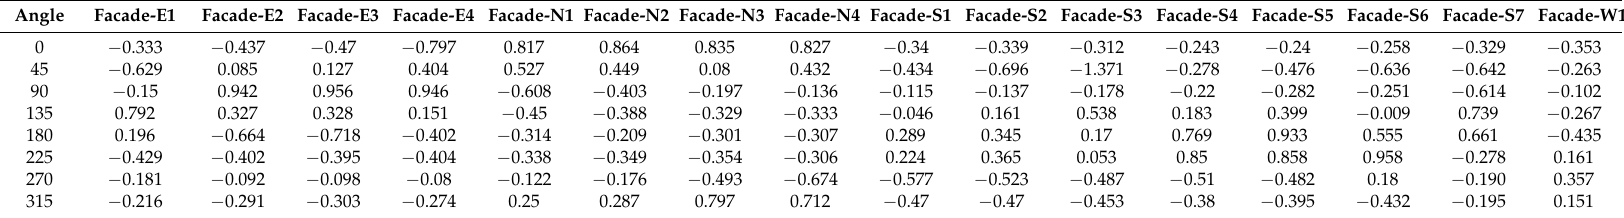
Table A1. Pressure coefficient in the openings of the case study building.